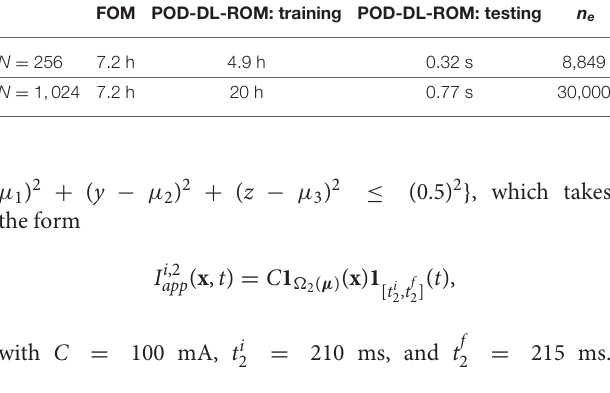
TABLE 4 | Test 3 : FOM and POD-DL-ROM computational times. FOM POD-DL-ROM: training POD-DL-ROM: